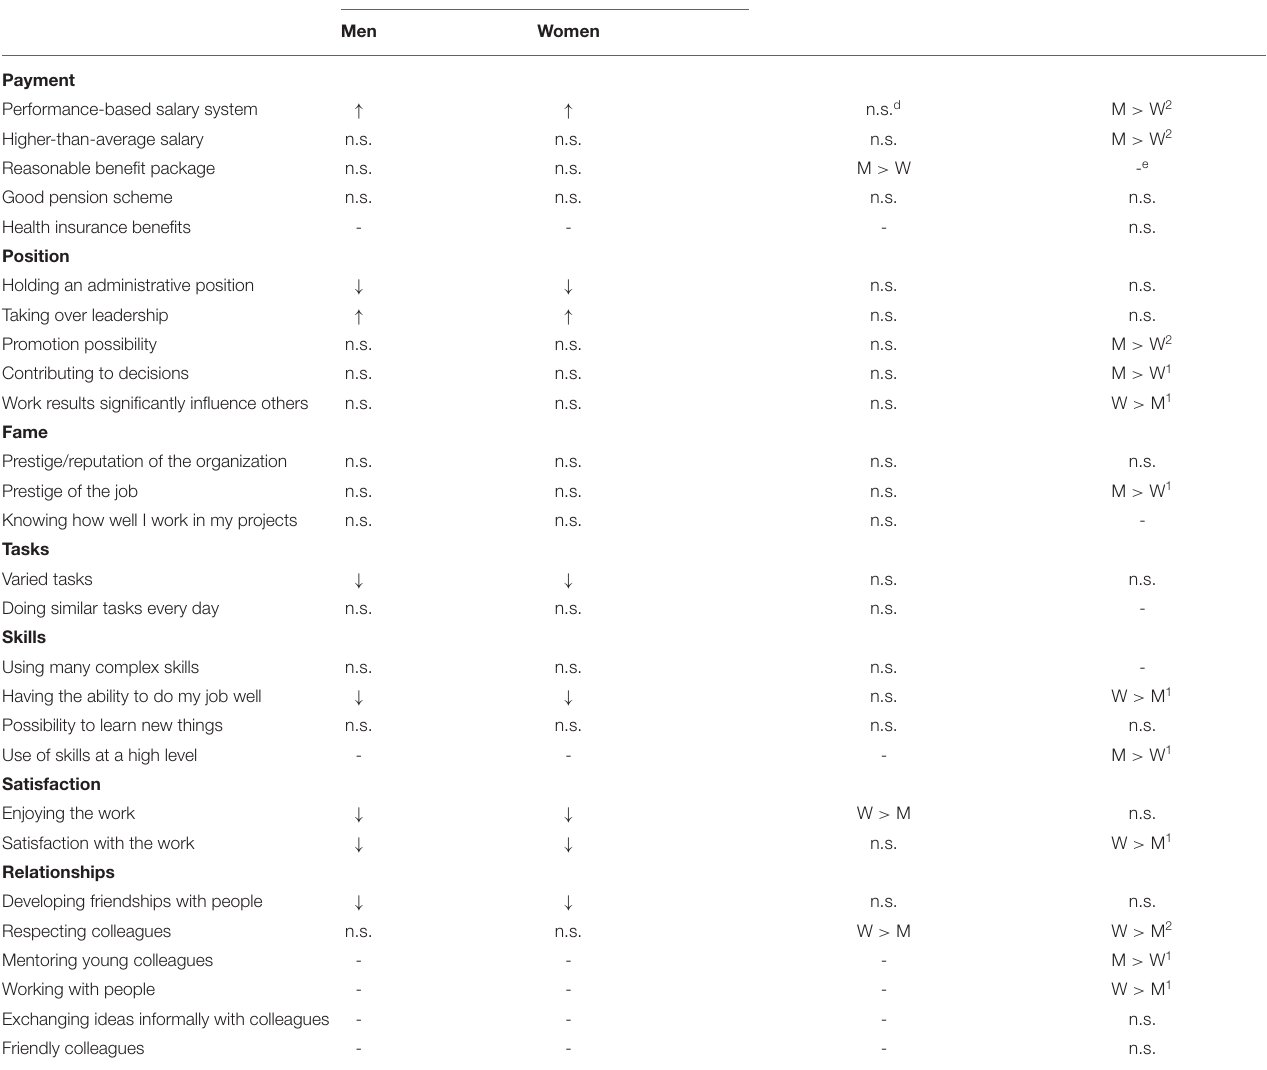
TABLE 4 | Work preferences by